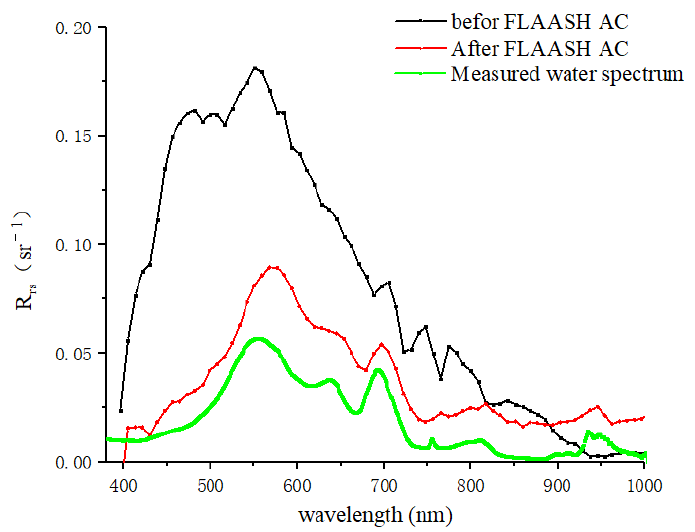
Figure 2. Comparison of the in situ measured water spectrum with the spectrum of the water bodies before and after atmospheric correction of the same pixel.